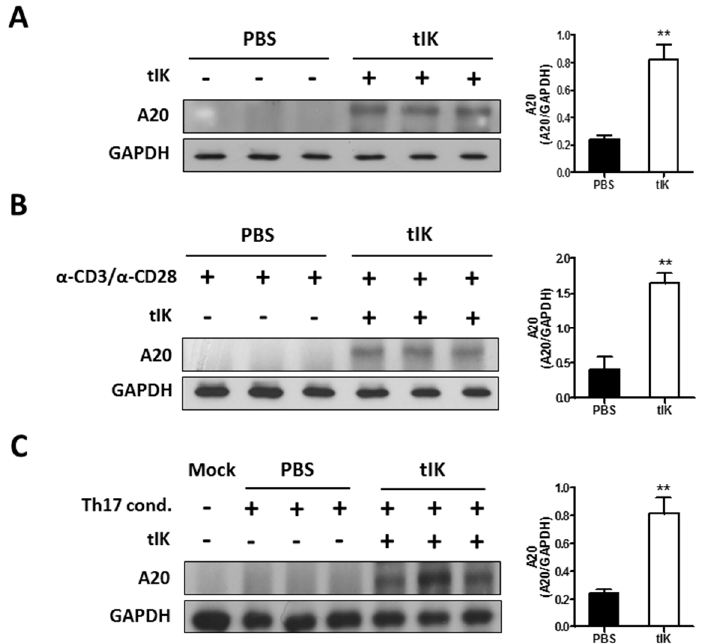
Figure 4. Treatment with tIK protein induces expression of A20, a negative regulator of inflammation in CD4 + T cells. ( A ) CD4 + T cells isolated from 7-week-old Balb/c mice using magnetic activated cell sorting were harvested 8 h after the tIK protein treatment and lysed using RIPA buffer containing a protease inhibitor cocktail. A20 was detected in the total extracted protein by Western blotting; ( B ) CD4 + T cells were isolated and stimulated with anti-CD3 and anti-CD28 antibodies (each 1 µ g/mL). The cells were harvested 8 h after the stimulation and tIK protein treatment. Protein from the cells was extracted and used for Western blot analysis as described in Figure 4A; ( C ) CD4 + T cells were isolated and differentiated into Th17 cells in Th17-polarizing medium. Protein was extracted from the cells cultured for 3 days and used for Western blot analysis as described for Figure 4A. PBS indicates non-treated (control) cells, tIK indicates tIK protein-treated cells. The amount of protein was normalized to that of glyceraldehyde 3-phosphate dehydrogenase (GAPDH) protein. The bar graph shows mean normalized data. Data is represented as the mean ± SD ( n = 3), ** p < 0.005.